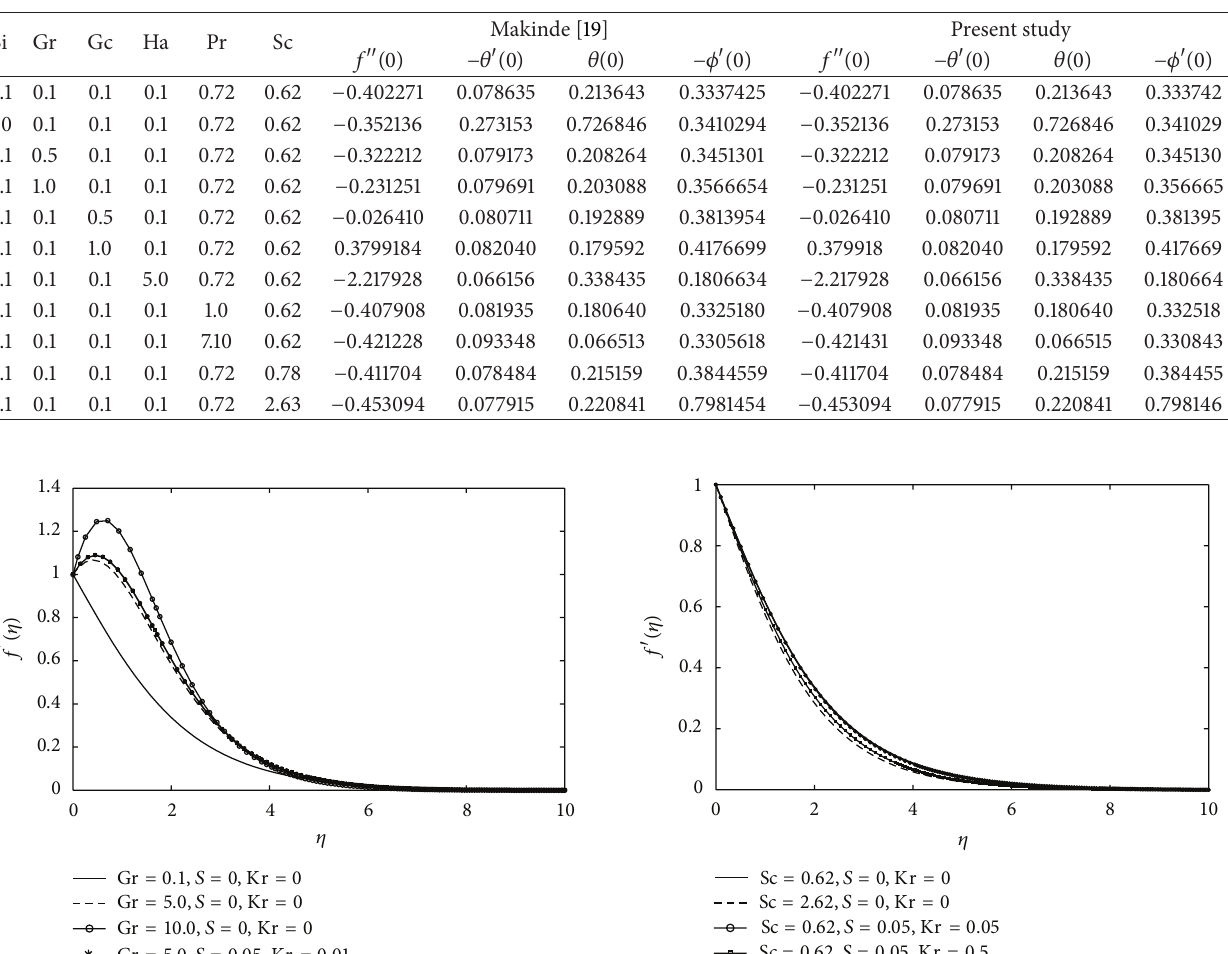
Table 1: Comparison of 𝑓 󸀠󸀠 (0) , −𝜃 󸀠 (0) , 𝜃(0) , and −𝜙 󸀠 (0) for various values of Bi, Ha, Gr, Gc, Pr, and Sc when Kr = 𝑆 = 0 .